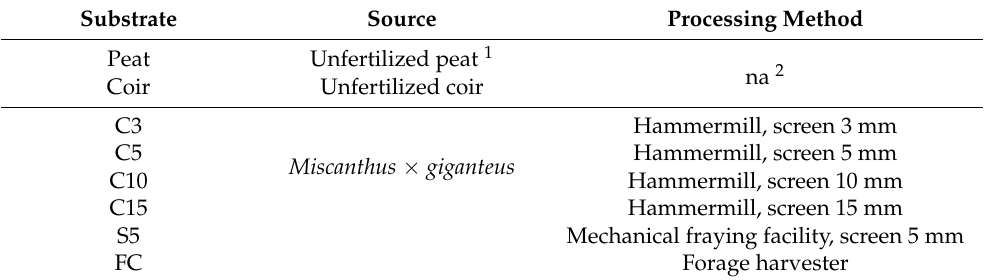
Table 1. List of tested growing